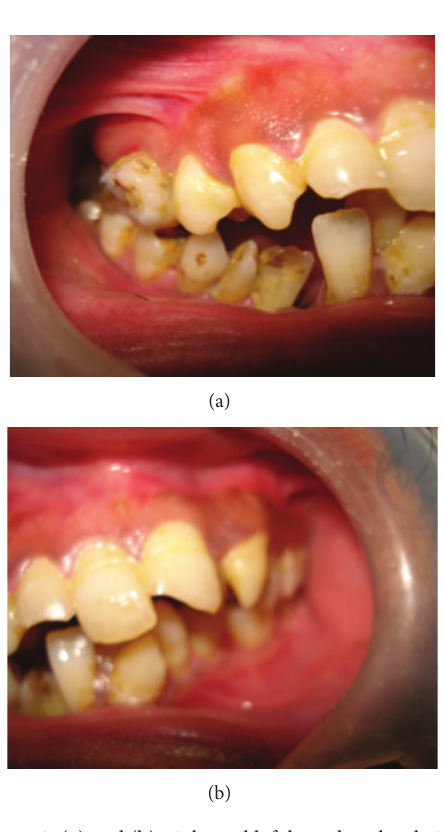
Figure 8: (a) and (b): right and left lateral occlusal